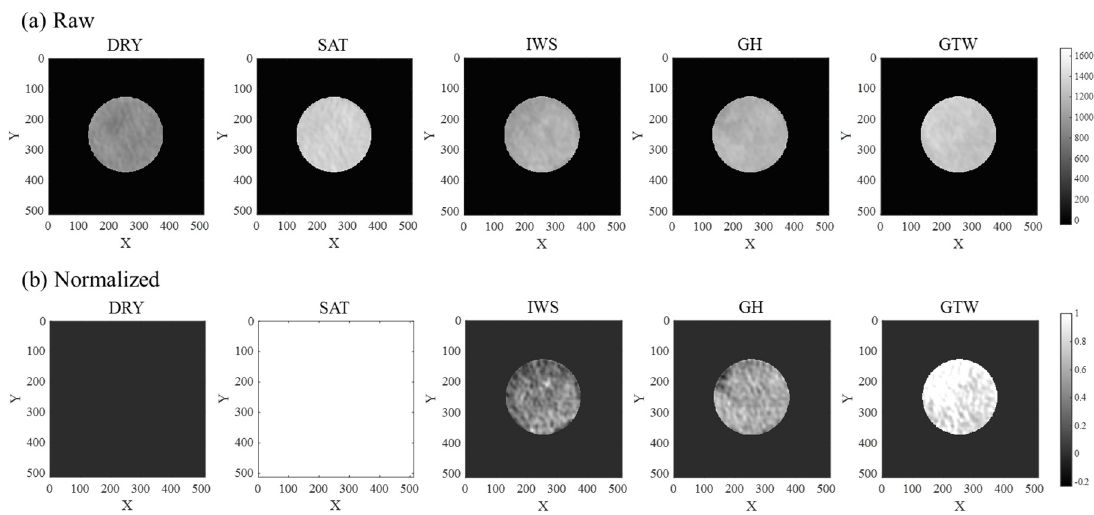
Figure 5. Examples of CT images for the first slice in sample B. ( a ) raw CT images of the five experimental stages; ( b ) normalized CT images for the five experimental stages.